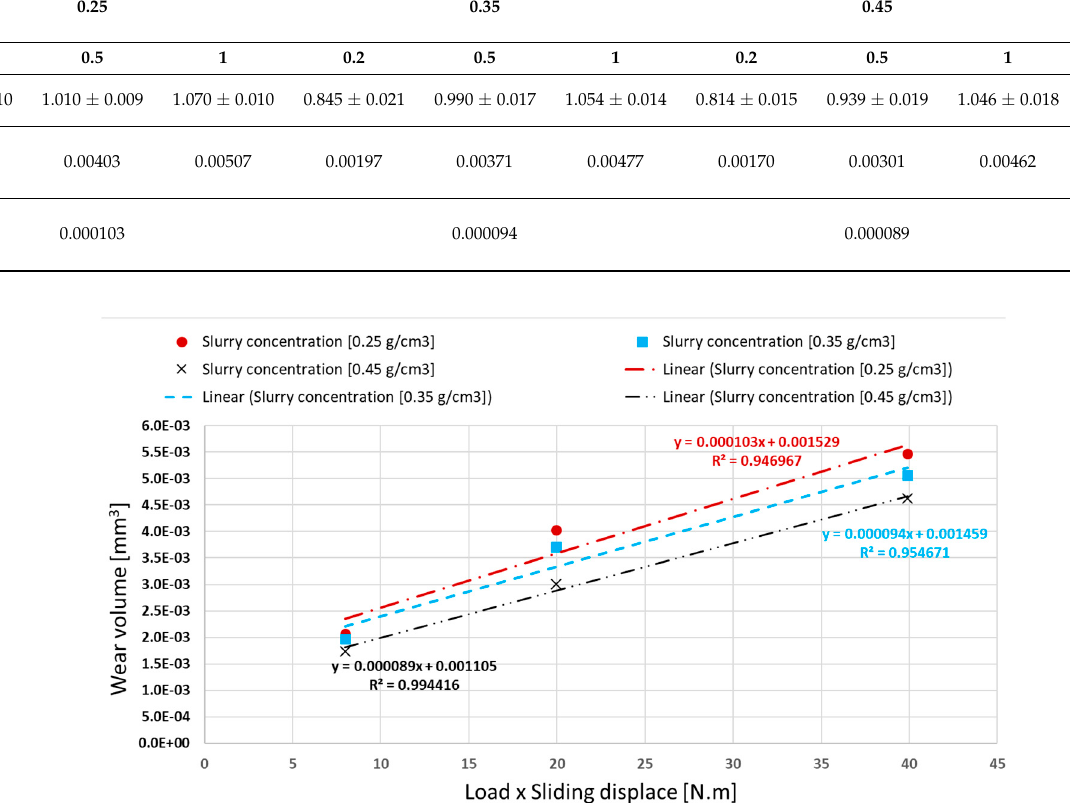
Figure 11. Results of application of Archard’s linear equation for specific wear rate for the test conditions.